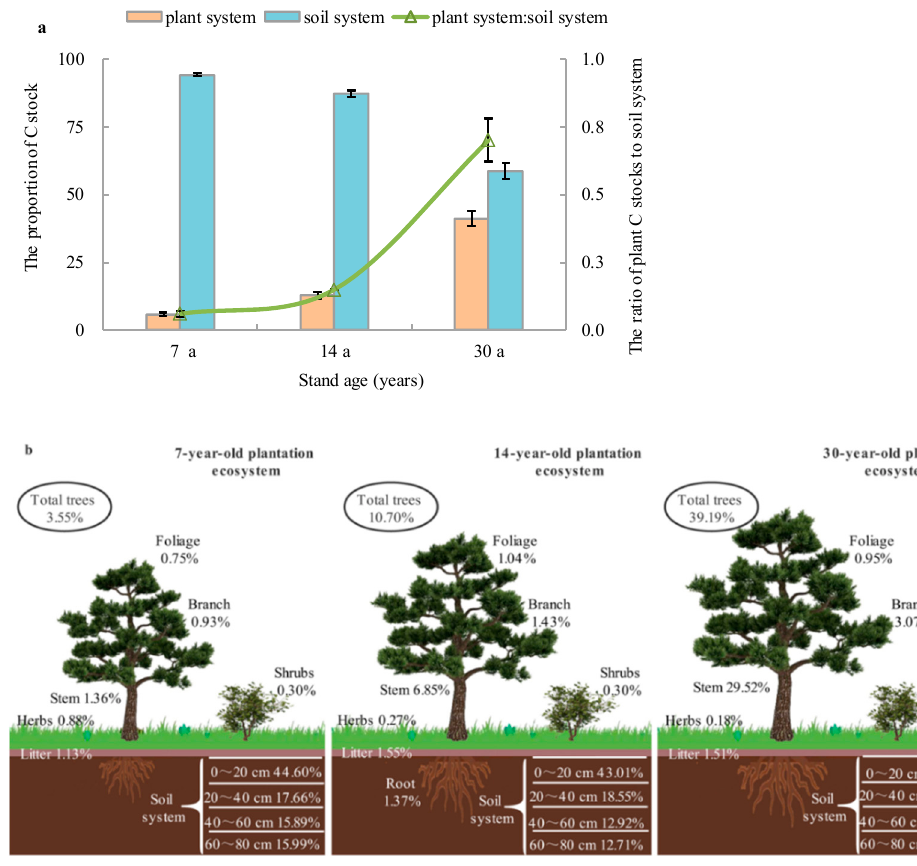
Figure 6. The proportions of C stock in Masson pine plantation ecosystems. ( a ) The proportions of C stock in systems; ( b ) The proportions of C stock in different components.